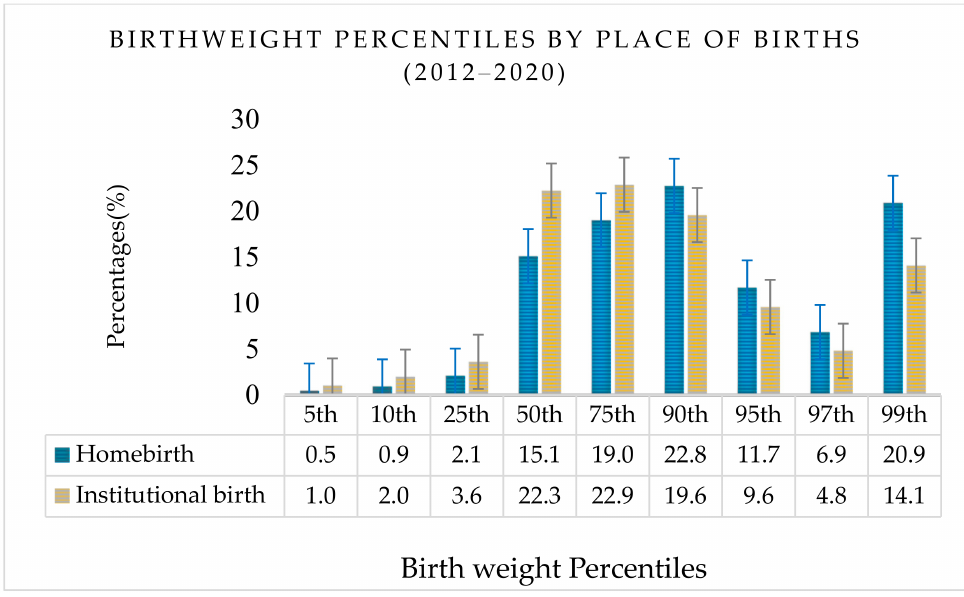
Figure 2. Birth weight percentiles by place of birth in Hungary